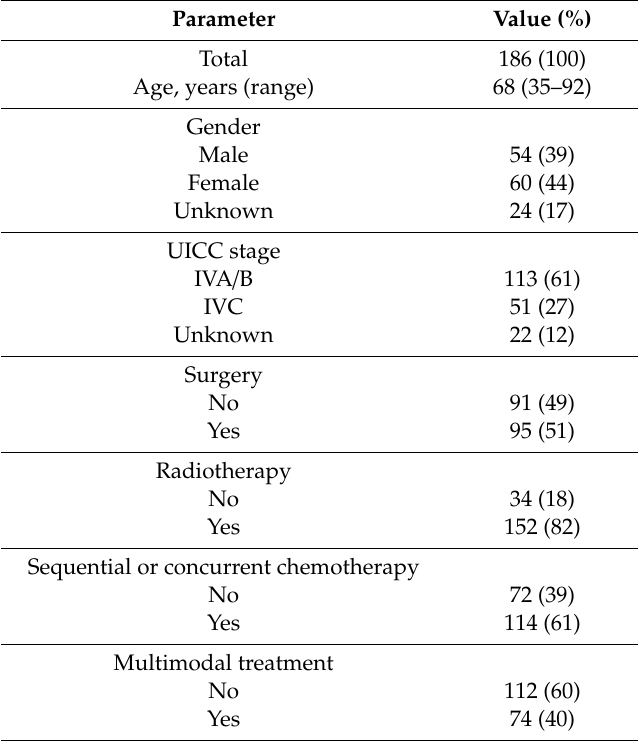
Table 2. Patient and treatment characteristics of the pooled patient